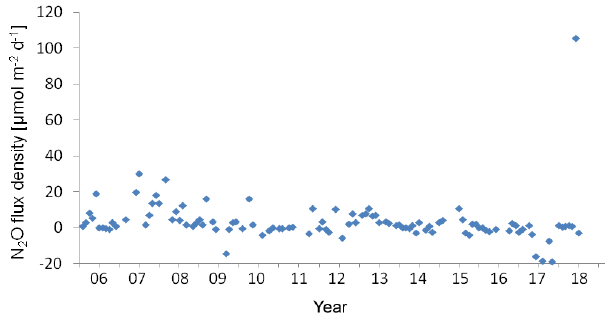
Figure 8. Variation of N 2 O flux density at the BE Time Series- Station during 2005–2017. Negative values indicated N 2 O influx from the atmosphere and positive values indicated N 2 O efflux to the